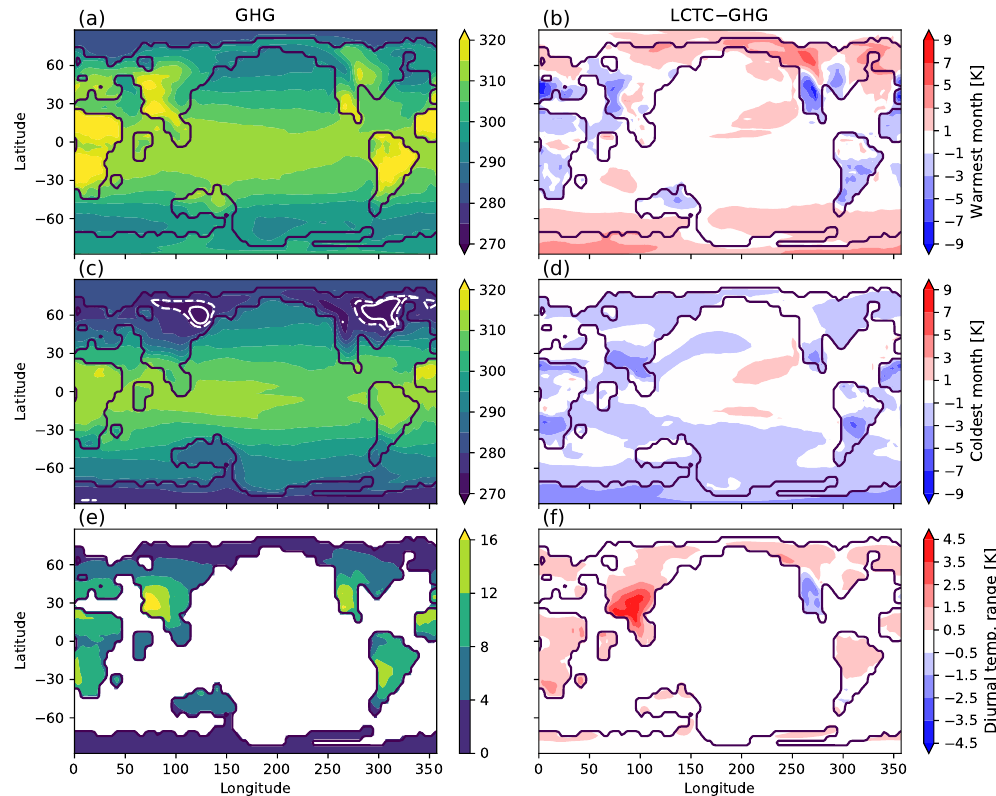
Figure 3. Monthly-mean surface temperature during the warmest month at each grid point in the GHG simulation (a) and its change in the LCTC simulation (b) . (c, d) Same as in (a, b) but for the coldest month. (e) Annual-mean diurnal range in surface temperature, defined as the difference between daily maxima and minima, and (f) its change in the LCTC case. White lines in (c) indicate the 0 ◦ C contour in the GHG case (solid) and the LCTC case